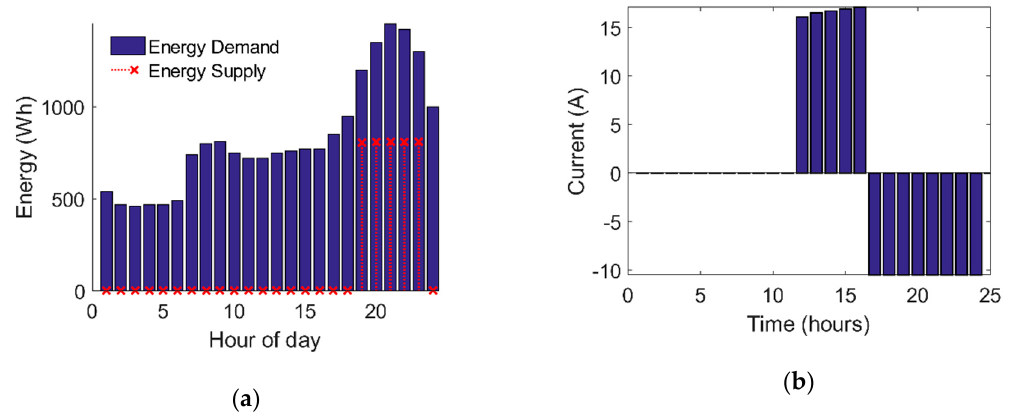
Figure 12. BESS operation schedule: ( a ) Energy distribution; ( b ) Charging and discharging currents.